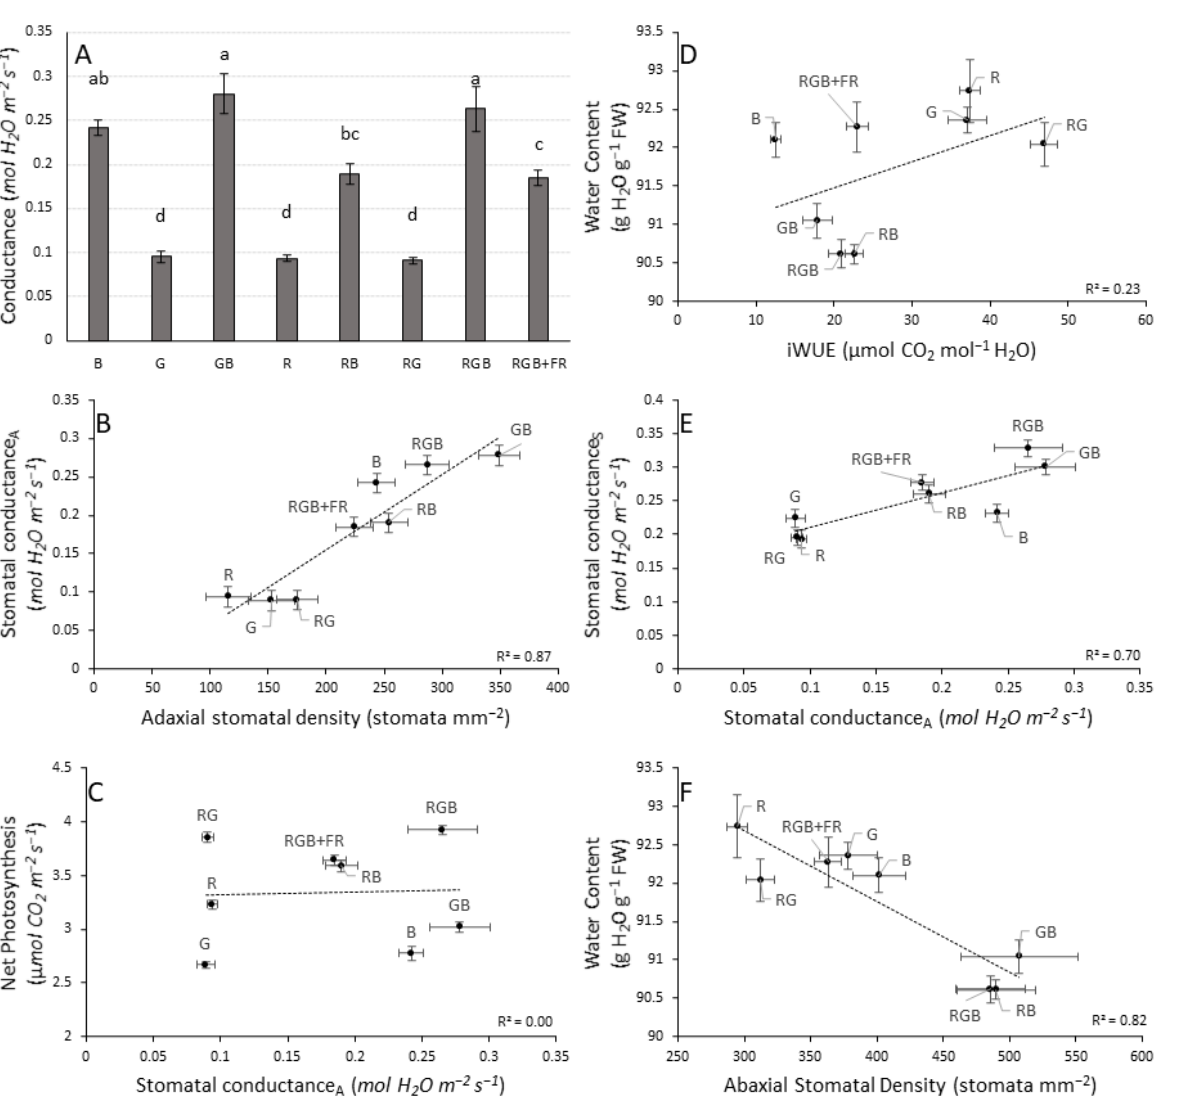
Figure 5. ( A ): Stomatal conductance under saturating light by light treatment. Different lowercase letters indicate significant differences ( p ≤ 0.05; n is between 25 and 30 for each treatment). ( B ): Stomatal conductance under ambient, treatment lighting (Stomatal conductance A ) vs. adaxial stomatal density. ( C ): Net photosynthesis under ambient, treatment lighting vs. stomatal conductance under ambient, treatment lighting. ( D ): Water content vs. instantaneous water use efficiency. ( E ): Stomatal conductance under saturating light vs. stomatal conductance under ambient, treatment lighting. ( F ): Water content vs. abaxial stomatal density. Uppercase letters indicate light